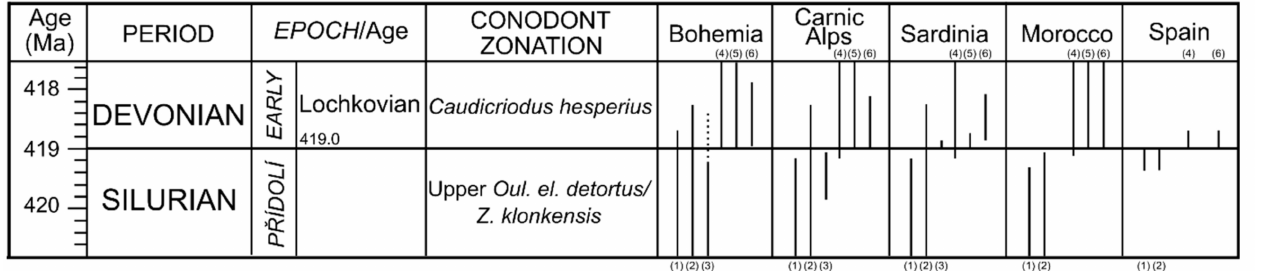
Figure 5. Correlation between conodont markers across the Silurian/Devonian boundary in the investigated areas. 1: Ozarkodina confluens ; 2: Oulodus elegans detortus ; 3: Zieglerodina klonkensis ; 4: Zieglerodina remscheidensis ; 5: Caudicriodus hesperius ; 6: Caudicriodus woschmidti . Aside from these species that widely occur in peri-Gondwana terranes and elsewhere, a few others show good potential for correlation of the uppermost Silurian and lowermost Devonian beds, but up to now are documented only locally or in a few areas, or are very rare. Among these, Z. eladioi , Z. petrae and Z. schoenlaubi should be mentioned. It is noteworthy to mention that the earliest icriodontids which represent the most reliable markers for the Silurian/Devonian boundary recognition are facies-limited and thus not represented or rare in most pelagic environments. According to our analyses, ozarkodinids are less sensitive to water depth; thus, they may have a more universal dispersal in oceanic waters. Therefore, an agreement on such a universal boundary marker of the spathognathodontid clade could be the future direction of our